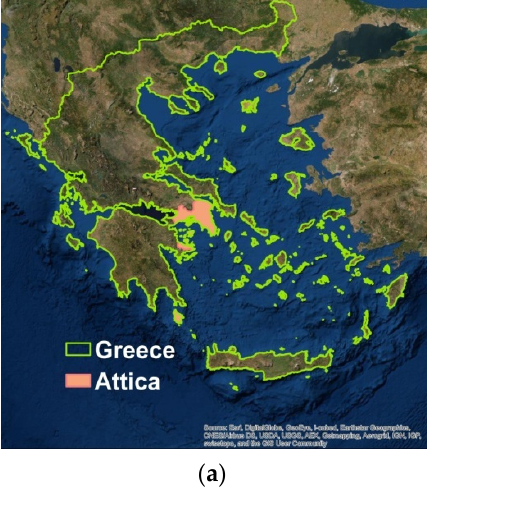
Figure 1. ( a ) Map of Greece and the Attica region and ( b ) the restaurants participating in the survey, spatially allocated in the regional units of Attica. Table 1. Statistical data for the commercial cooking activities in the GAA for the year 2017 (Source: Hellenic Statistical Authority).